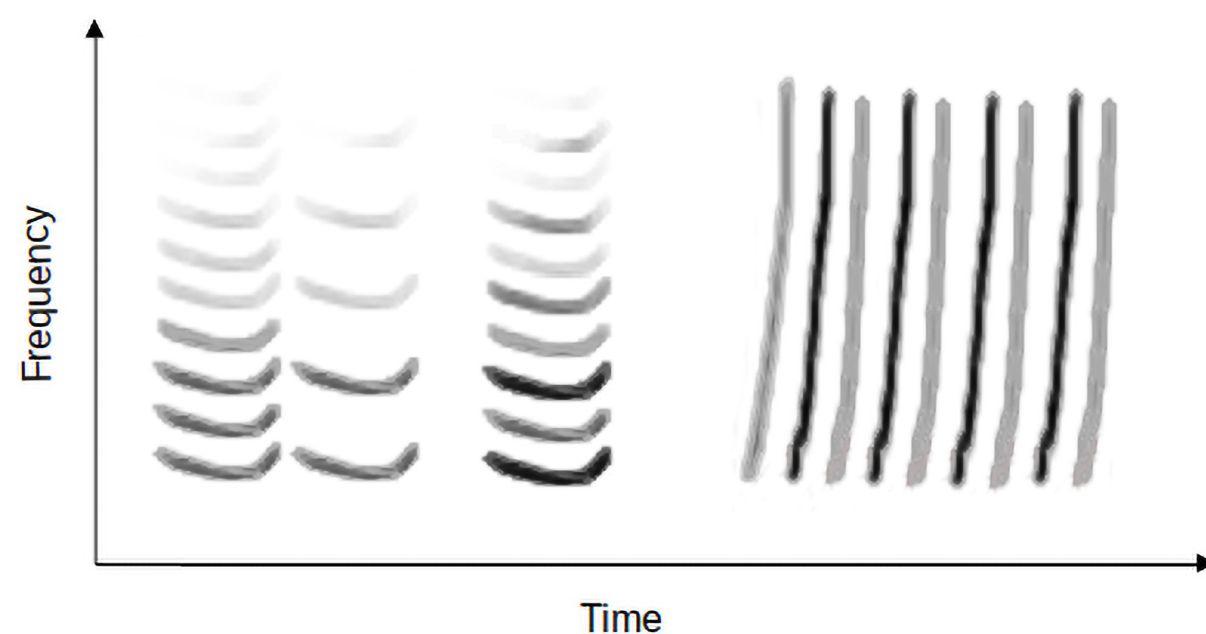
S1 Fig. Avian example spectrograms used for feature scoring training. Tone, interval, rhythm (top row), repetition, transposition, and syllable count (bottom row) from low (left) to high (right) within each series. The syllable counts (bottom right) are: 1, 2, 3, 3, 3, 4 (approxi- mately). S2 Fig. Boxplots of average pairwise differences between scorer combinations. First all pos- sible 10 pairs of 5 scorers’ scores were subtracted from one another ( top ). Then the means of pairs were subtracted from means of the remainder triads to generate differences at these higher level aggregates ( bottom ). The contrast between top and bottom plot series demon- strates that while individual scores may not be extremely individually reliable, their aggregated (mean) values, between multiple scorers, are substantially less